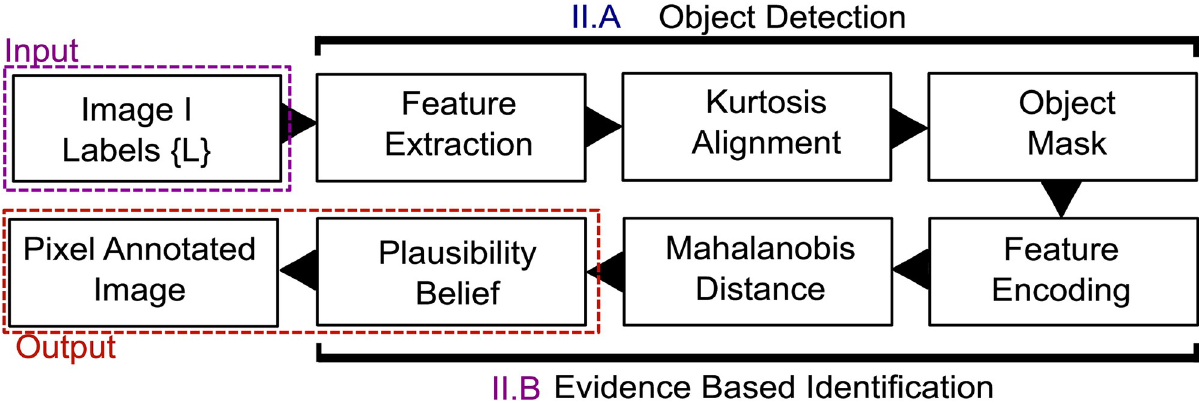
Fig 1. SPECHT algorithm. Adaptive identification of subcellular structures in superresolution microscopy in tandem with belief based labelling of each object’s support for the cell level genotype. Each image can have a set of labels, SPECHT then computes for each identified object o the support it has per individual